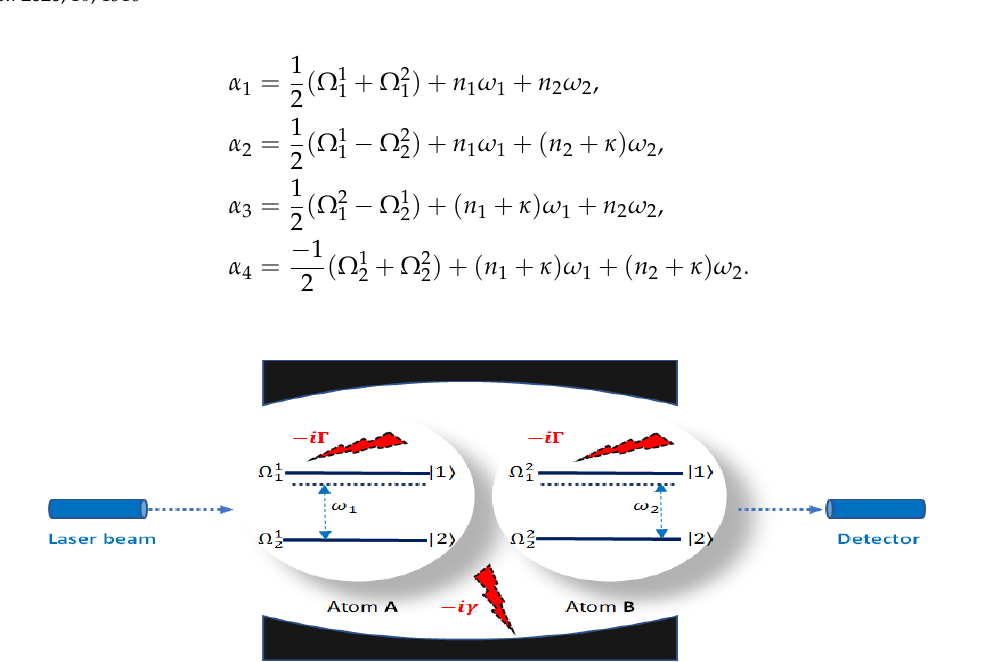
Figure 1. Energy level diagram of two two-level atoms coupled to two-mode field in a dissipative